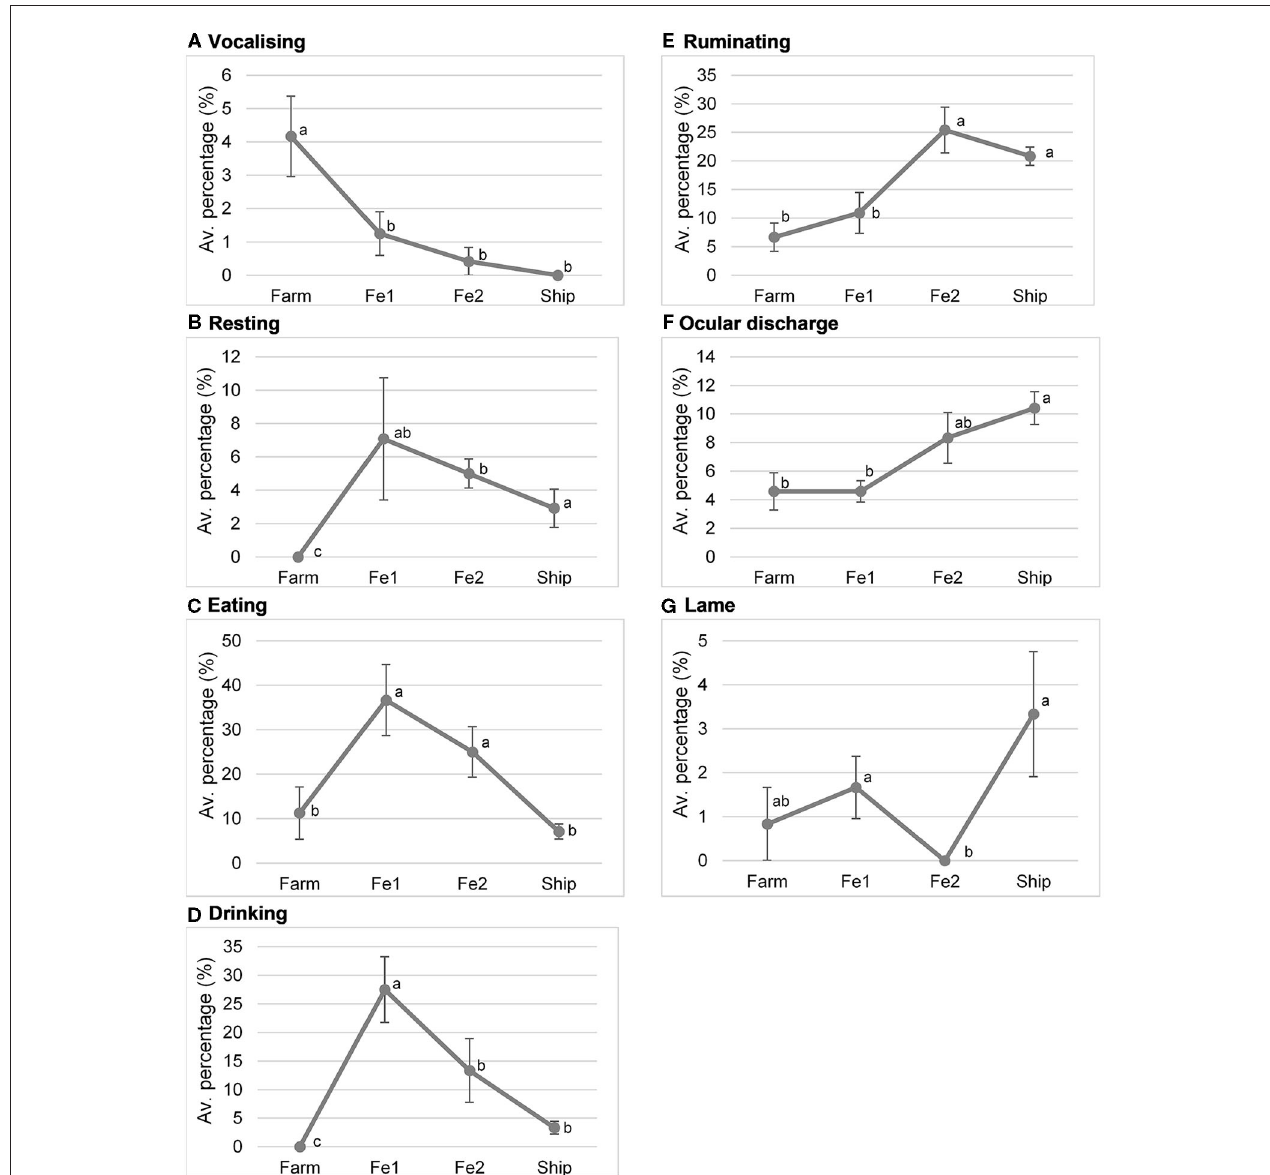
FIGURE 1 | Average percentage ( ± std error) of animals scored for (A) ocular discharge, (B) lame, (C) vocalizing, (D) eating, (E) drinking, (F) ruminating, (G) resting across the four locations as part of the live export supply chain ( n = 48 per location/timepoint). Note: letters link locations that were not significantly different to each other through square root Repeated Measures ANOVA analysis ( p <